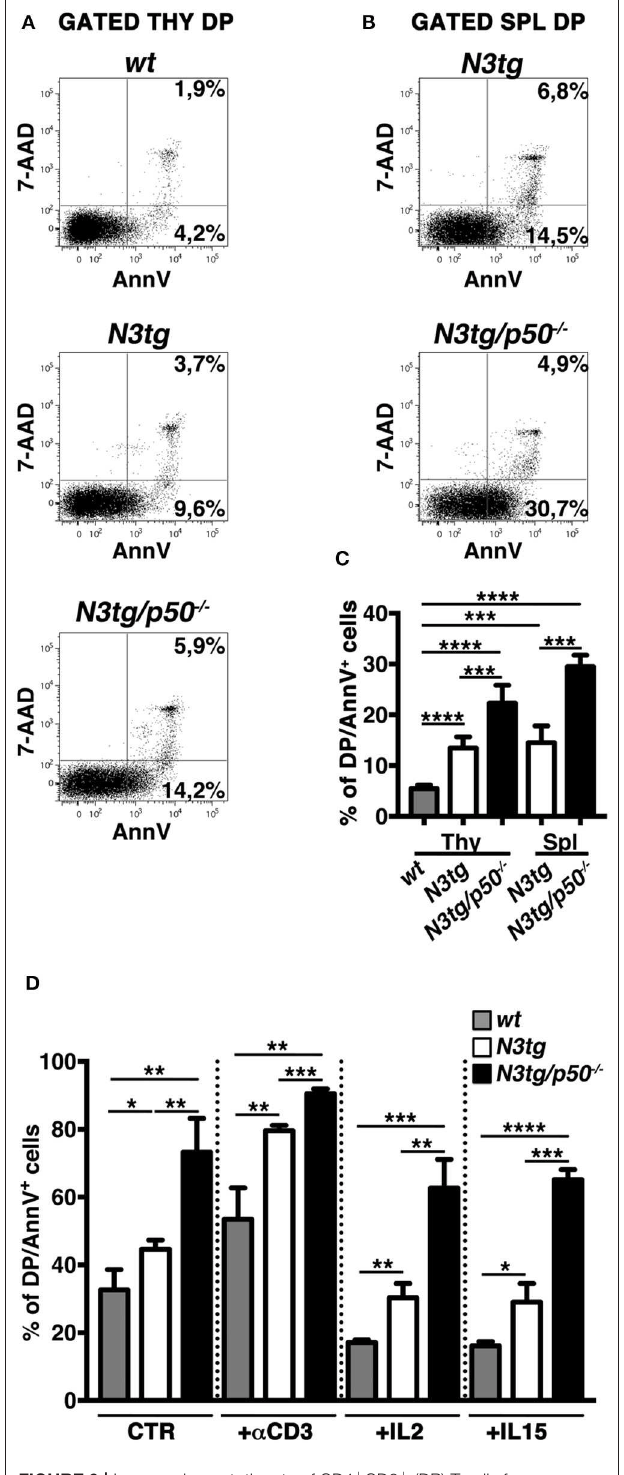
FIGURE 9 | Increased apoptotic rate of CD4 + CD8 + (DP) T cells from N3tg/p50 − / − mice. Representative dot plots of 7AAD/Annexin V distributions inside gated CD4 + CD8 + (DP) T cells from thymus (A) and spleen (B) of N3tg/p50 − / − vs. N3tg mice at 4–5 weeks of age. DP thymocytes from wt